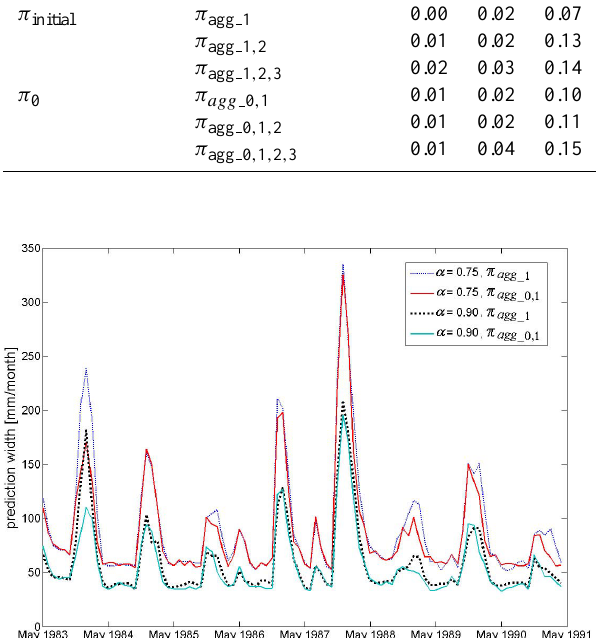
Fig. 10. Prediction width at the possibility levels α =0.75 and α =0.90 for the aggregate possibility distributions π agg 1 and π agg 0 , 1 during the verification